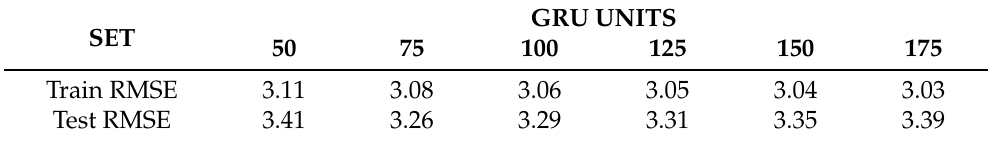
Table 4. Average RMSE for GRU model with attention mechanisms against GRU unit variance.